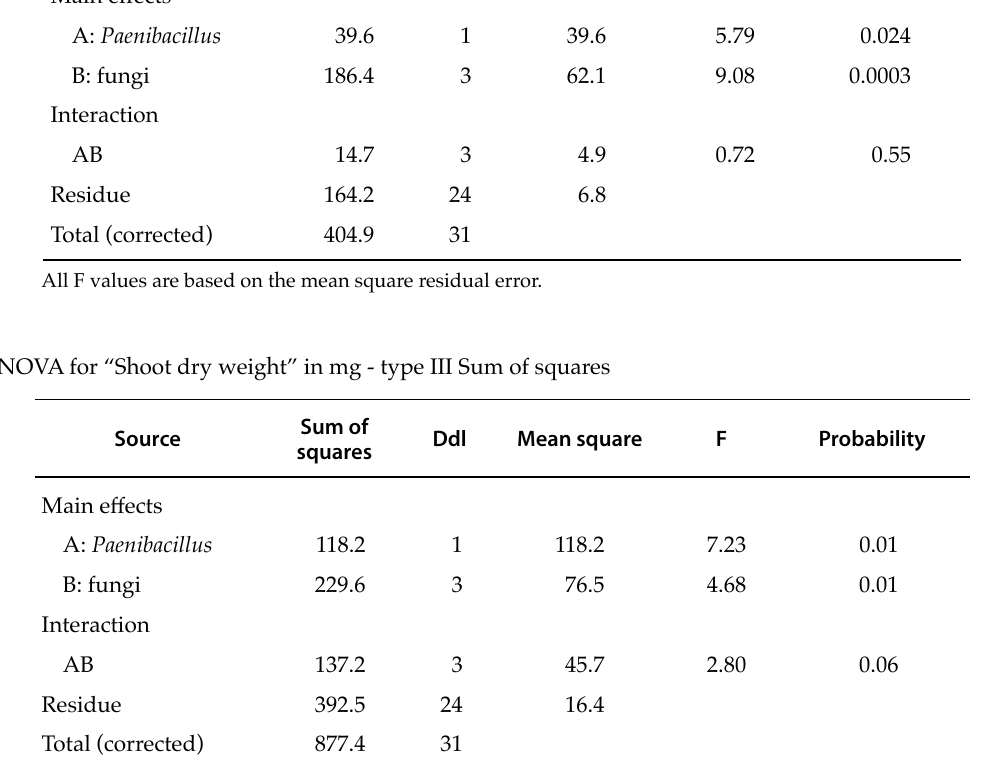
Total (corrected) 877.4 31 All F values are based on the mean square residual